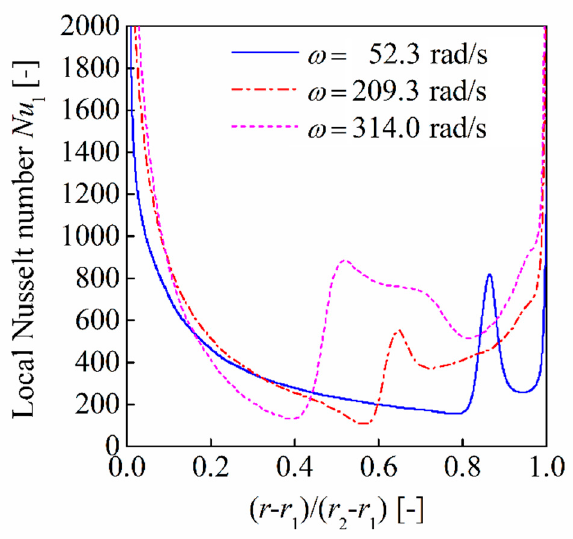
Figure 13. Results of the local Nusselt number on the stationary disk surface along the radial direction.